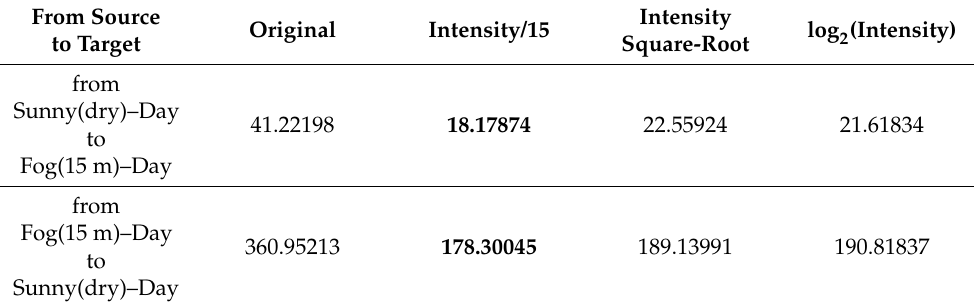
Table 3. Intensity error results depending on LiDAR data format. The numbers in the table indicate intensity errors. The bold numbers prove that the most optimal format is